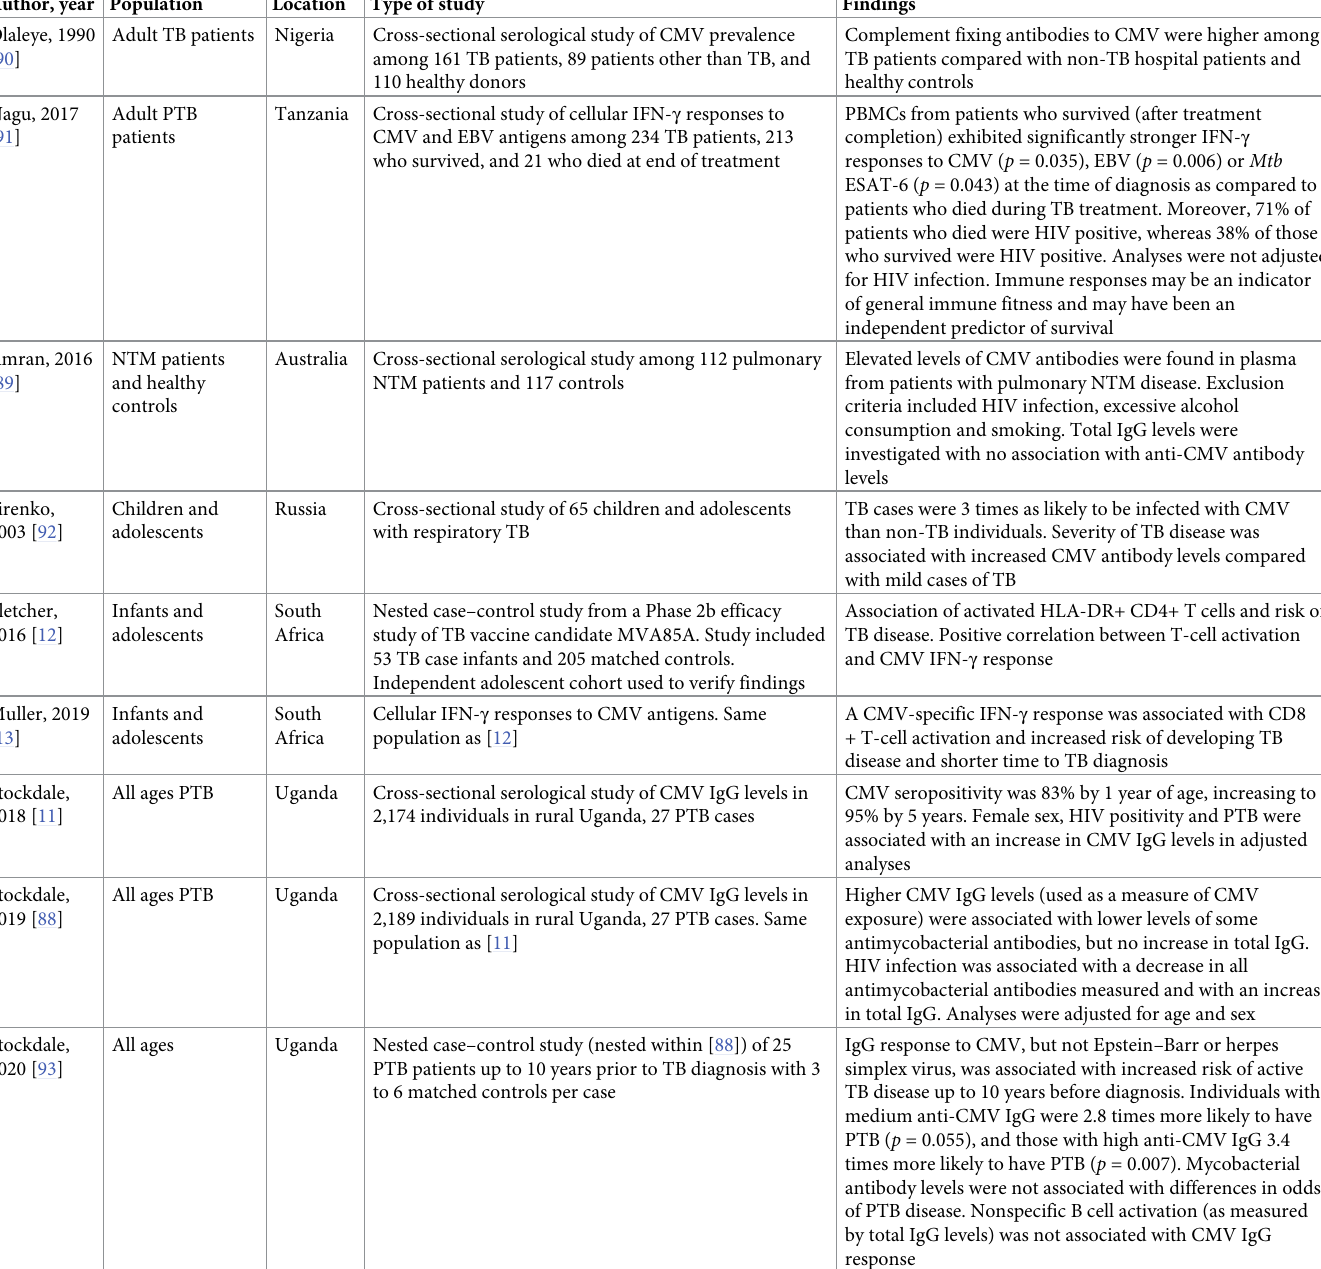
Table 1. Studies that have evaluated the interaction between TB and